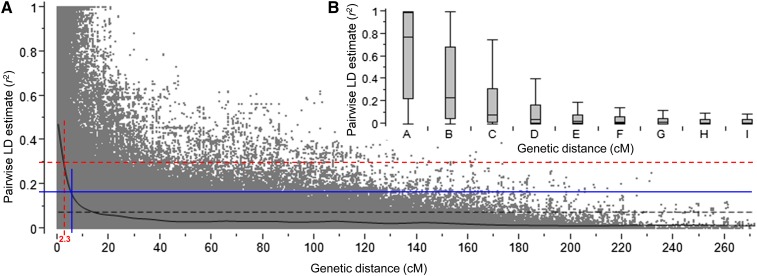
Genome-wide average linkage disequilibrium (LD) decay over genetic distance. (A) Plot of pair-wise SNP LD r2 values as a function of intermarker map cM distance based on a reference consensus map (Cavanagh et al. 2013). The curve represents the model fit to LD decay. The red dashed line represents the standard critical r2 = value (0.3) used for establishing QTL confidence intervals in this study; the blue solid line represents the population-specific critical r2 value (0.16) beyond which LD is likely due to linkage; and the black dashed line represents the mean. (B) Boxplot showing LD r2 values for categories of SNP pairwise map distances (A–I): 0, 0.1–1, 1.1–5, 5.1–10, 10.1–20, 20.1–30, 30.1–40, 40.1–50, and > 50 cM. SNP, single nucleotide polymorphism.